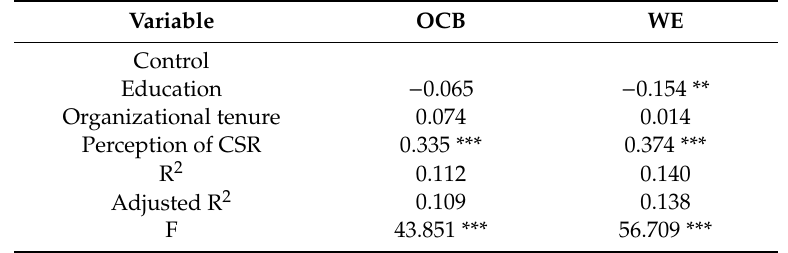
Table 3. Regression analysis results of perception of CSR, OCB, and work engagement (WE).